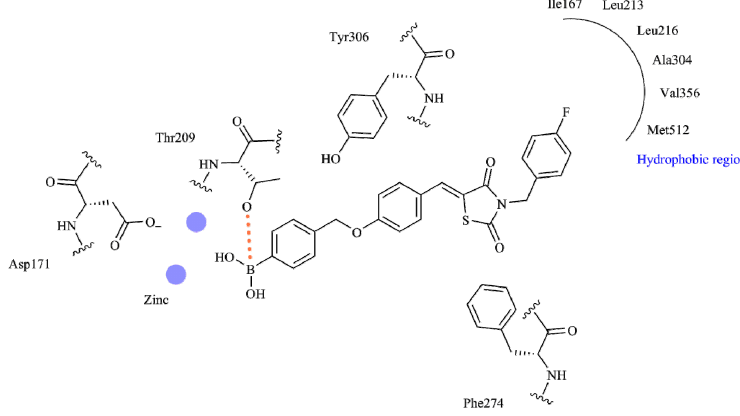
Figure 1. Schematic representation of the covalent bond as orange dashed lines between compound HA155 and neighboring residues of the autotaxin (ATX) active site.